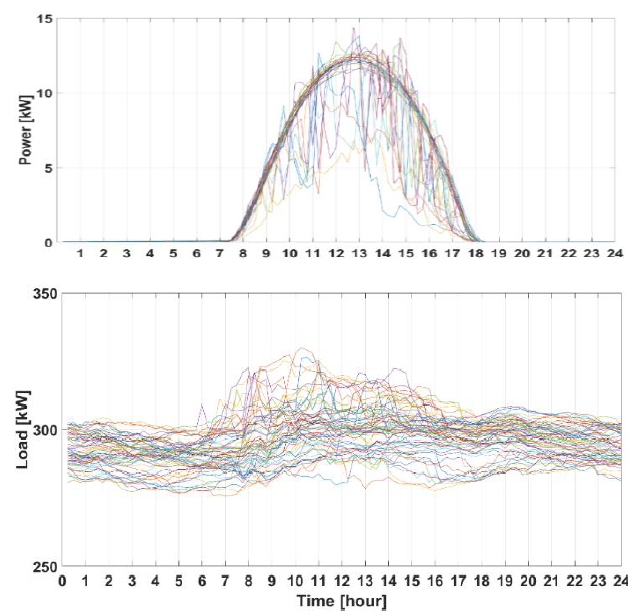
Figure 4. Daily 17.5-kW PV generation and pump station load data of NELHA (with 15-min. time